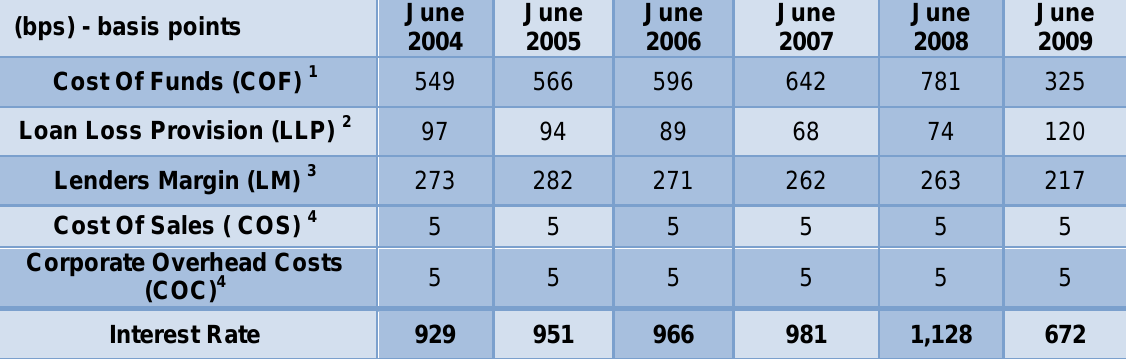
Table 1: An Example - the Cost plus Pricing Technique Assumptions